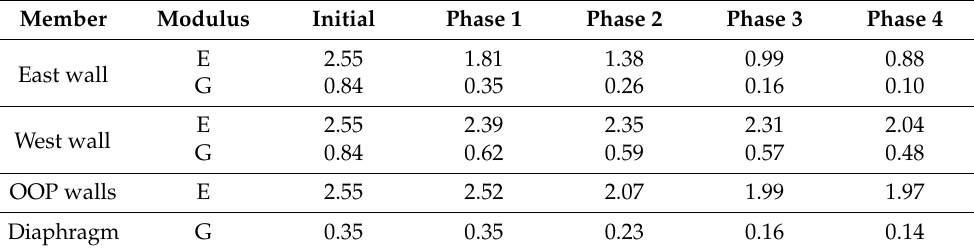
Figure 8. Comparison of the acceleration responses for strong motion tests between experimental recordings and the calibrated FE model in point B for test phases 1 to 4 from ( a – d ) respectively. Table 3. Elastic (E) and shear (G) moduli in GPa for each test phase of the building’s structural